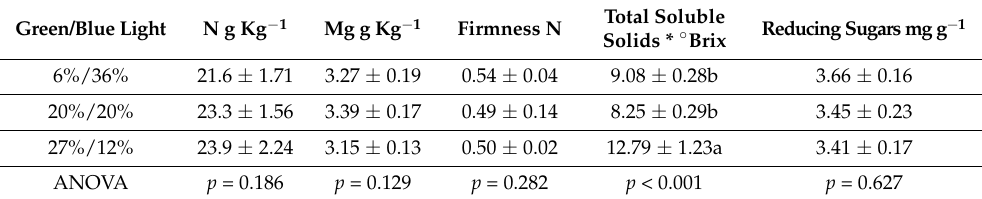
Table 6. Effect of the green (500–600 nm) and blue (400–500 nm) light balance on N and Mg nutrient status in leaves and on quality parameters in fruits of strawberry plants grown in an indoor vertical system with LED lighting.